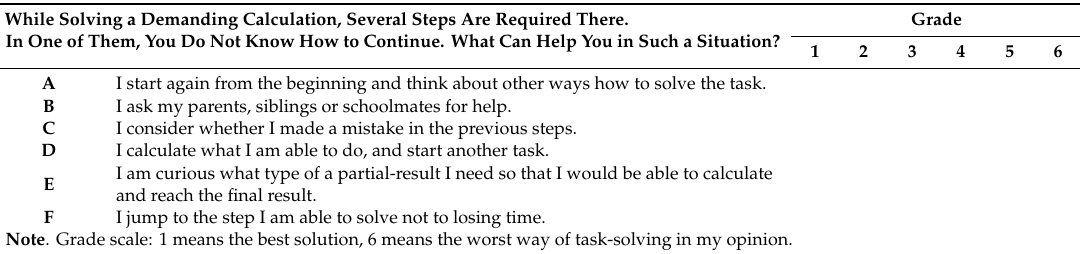
Table 1. A sample of specific scenario of the MAESTRA 5-6 +